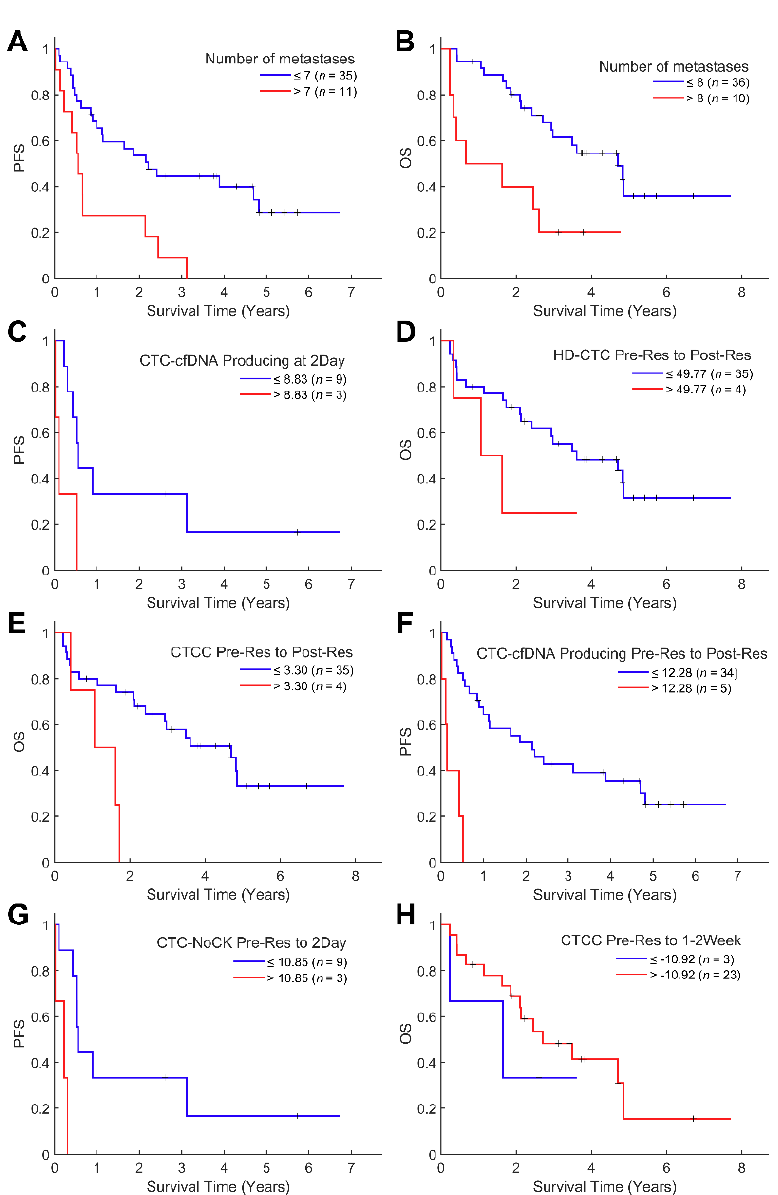
Figure 3. Kaplan–Meier survival analysis of mCRC patient cohort. ( A ) Patients with 7 or fewer metastases had longer PFS. ( B ) Patients with 8 metastases or fewer had longer OS. ( C ) Patients with 8.83 CTC-Apoptotic/mL or less in 2-day draw had longer PFS. ( D ) Patient with ∆ 49.77 HD-CTCs or less between pre-resection and post-resection draws had longer OS. ( E ) Patients with ∆ 3.30 CTCC/mL or less between pre-resection draws and post-resection draw had longer OS. ( F ) Patients with ∆ 12.28 CTC-Apoptotic/mL or less between pre-resection and post-resection draws had longer PFS. ( G ) Patient with ∆ 10.85 CTC-NoCK/mL or less between pre-resection and 2 days post-resection draws had longer PFS. ( H ) Patients with ∆ − 10.92 CTCC/mL or less between pre-resection